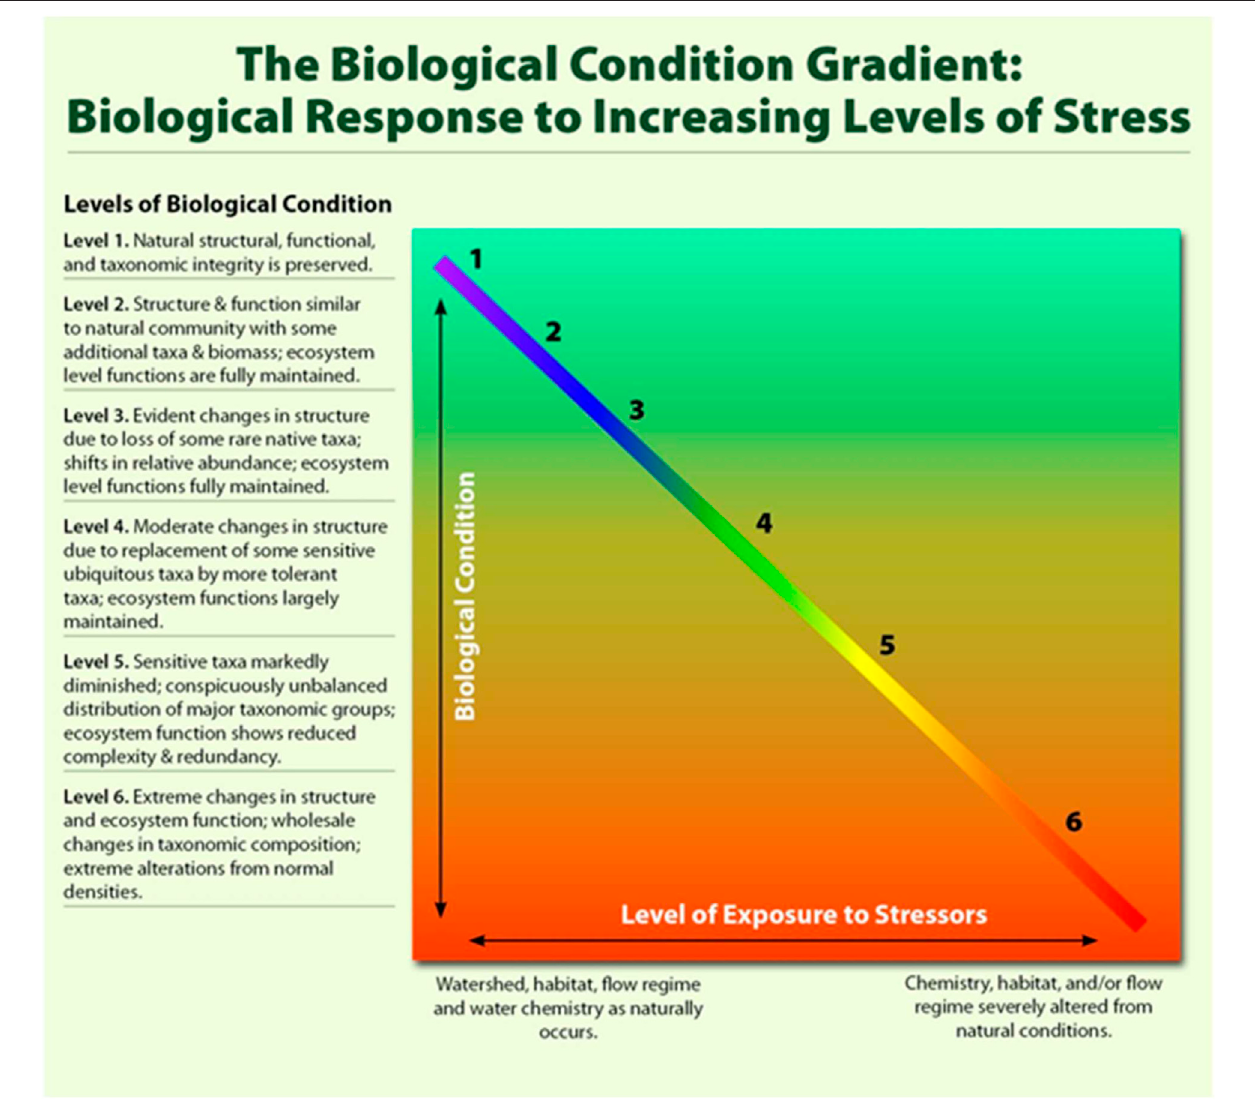
FIGURE2| ConceptualmodeloftheBCG.Althoughinreality,therelationshipbetweenstressorsandtheircumulativeeffectsonthebiotaislikelynonlinear,andthe relationship is presented as such to illustrate the concept (adapted from USEPA, 2016).